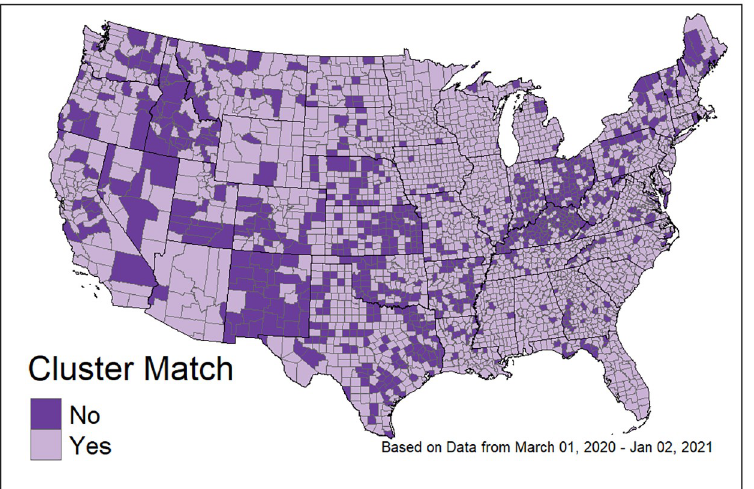
Fig 7. Map of the prediction accuracy of the multinomial logistic model describing the time series cluster solution. Counties in light purple (labeled Yes) were correctly classified with the model. Counties in dark purple (labeled No) were incorrectly